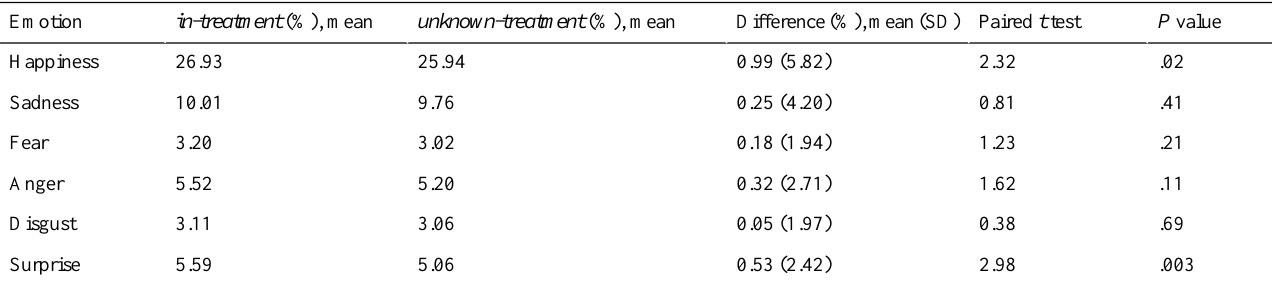
Table 6. Mean percentages of different emotions compared between in-treatment and unknown-treatment